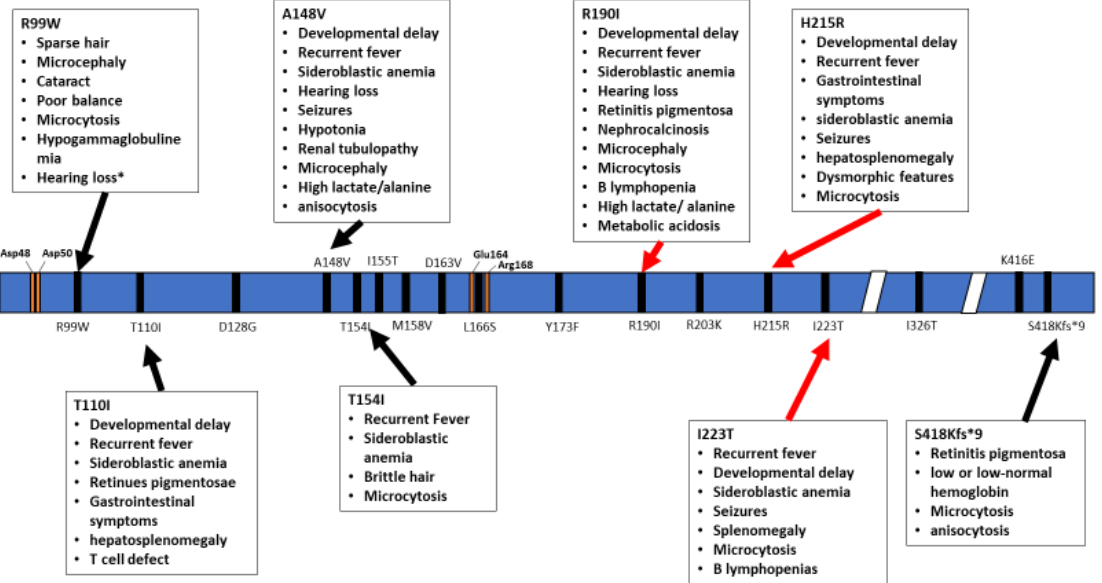
Figure 2. Schematic representation of the TRNT1 protein, with indicated positions of homozygous mutations in TRNT1. The specific phenotypes associated with these mutations are listed in boxed above and below the protein. Red arrows indicate severe symptoms while black arrows indicate mild phenotype. Orange marks indicate the active site as well as important residues to active site function.